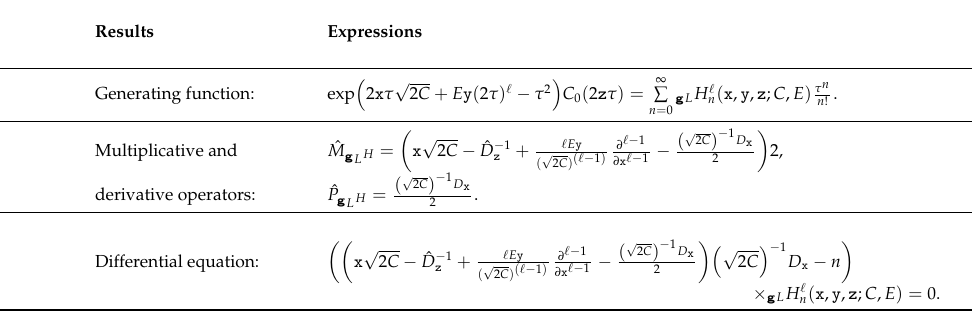
Table 3. Results for the GHLHMaP g L H (cid:96) n ( x , y , z ; C , E ) .